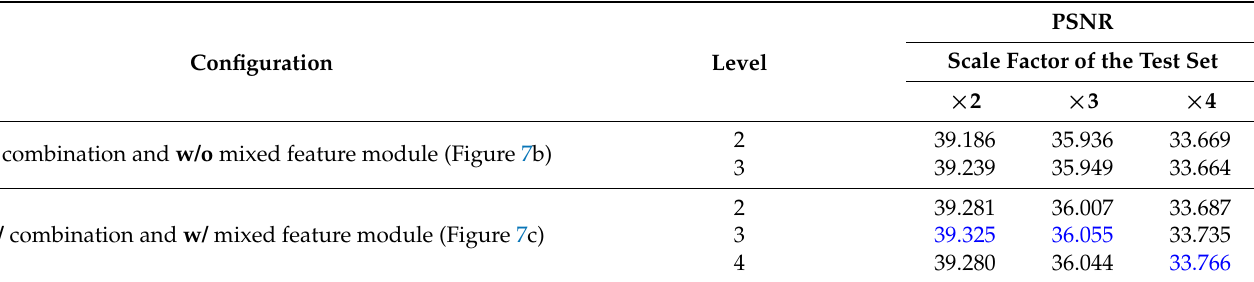
Table 4. Performance of multi-level networks (blue-colored: the best case).